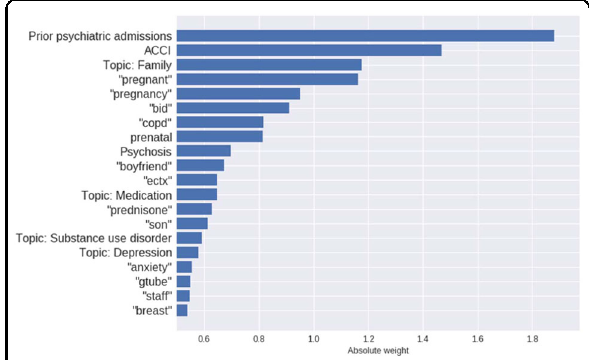
Fig. 1 Weights for most important features in logistic regression model.